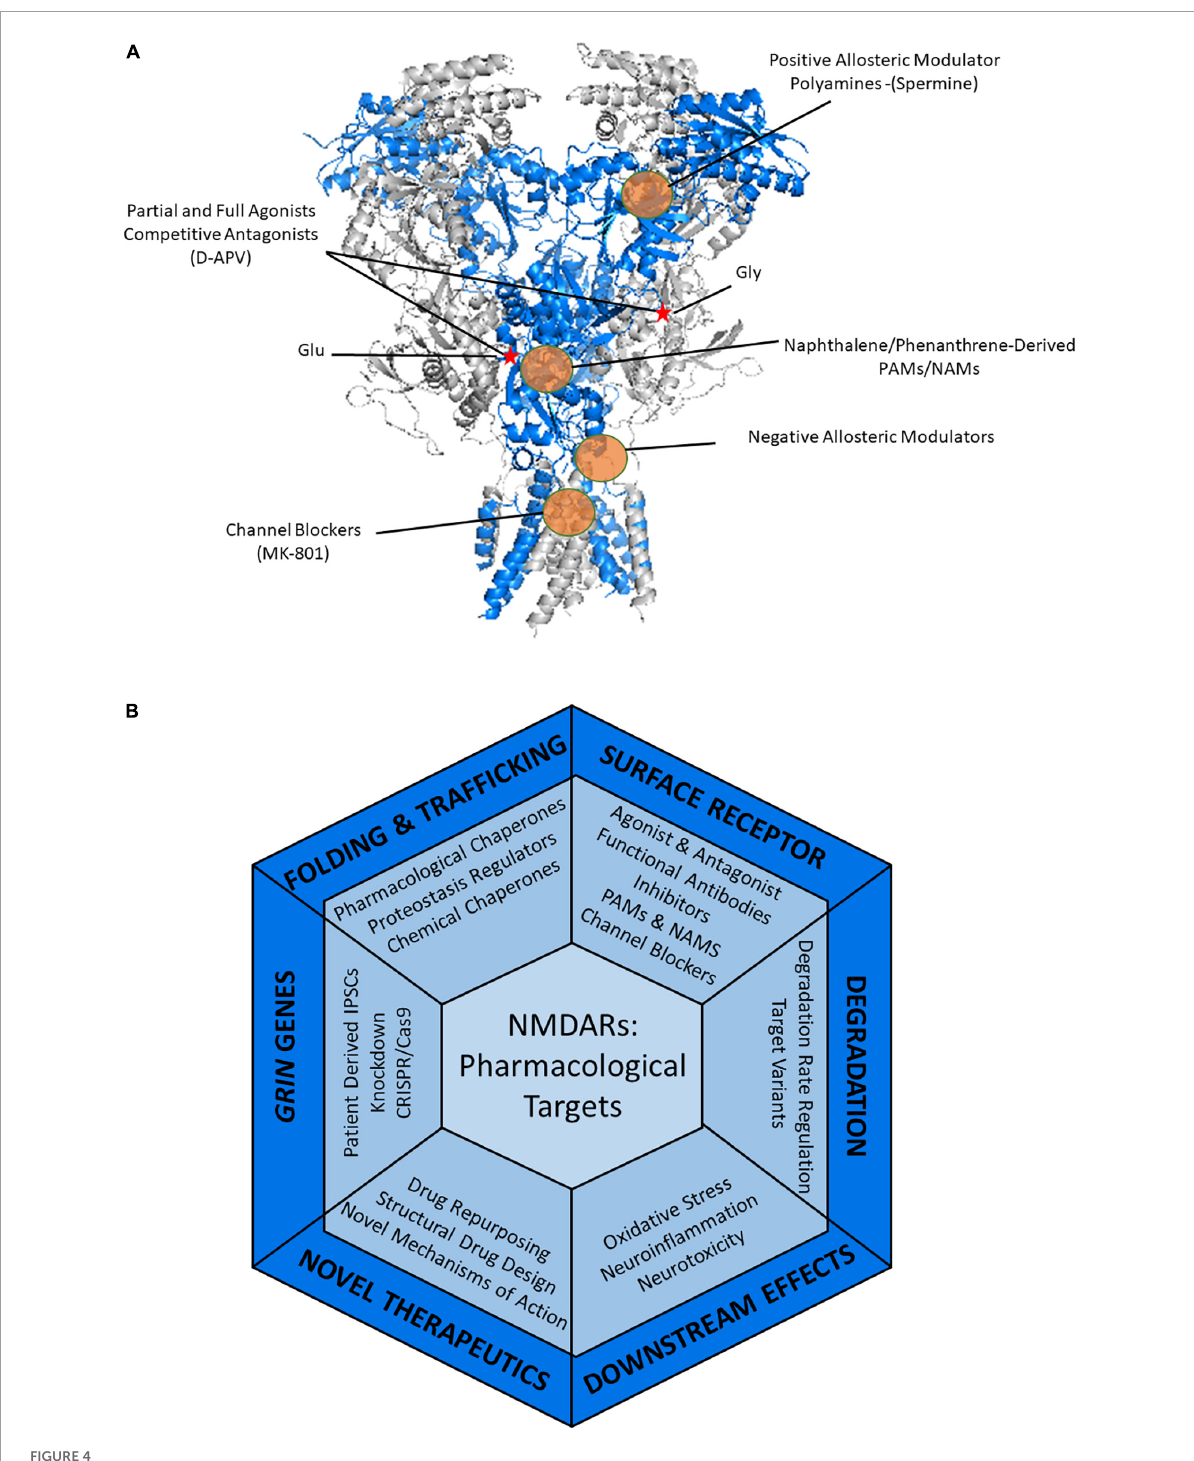
FIGURE4 Therapeutic strategies to treat NMDAR-related diseases. (A) Pharmacology of NMDARs. Heterotetrameric structure of rat GluN1_GluN2B (PDB: 4PE5) with the GluN1 in gray and the GluN2B shown in blue. Glutamate and glycine binding sites are indicated by a red star. Examples of known modulatory sites of different pharmacological agents targeting NMDARs are highlighted by the orange circles. GluN2B selective molecules, such as ifenprodil and polyamines including spermine, bind in the ATD of NMDARs. Agonists and antagonists of NMDARs bind within the LBD. Positive and negative allosteric modulators can act within the LBD and throughout the TMD regions. Channel blockers, such as memantine and MK-801 bind within the pore in the TMD, thus blocking the channel. (B) Current and potential pharmacological and therapeutic approaches to target the NMDARs containing disease-associated variants throughout the protein quality control